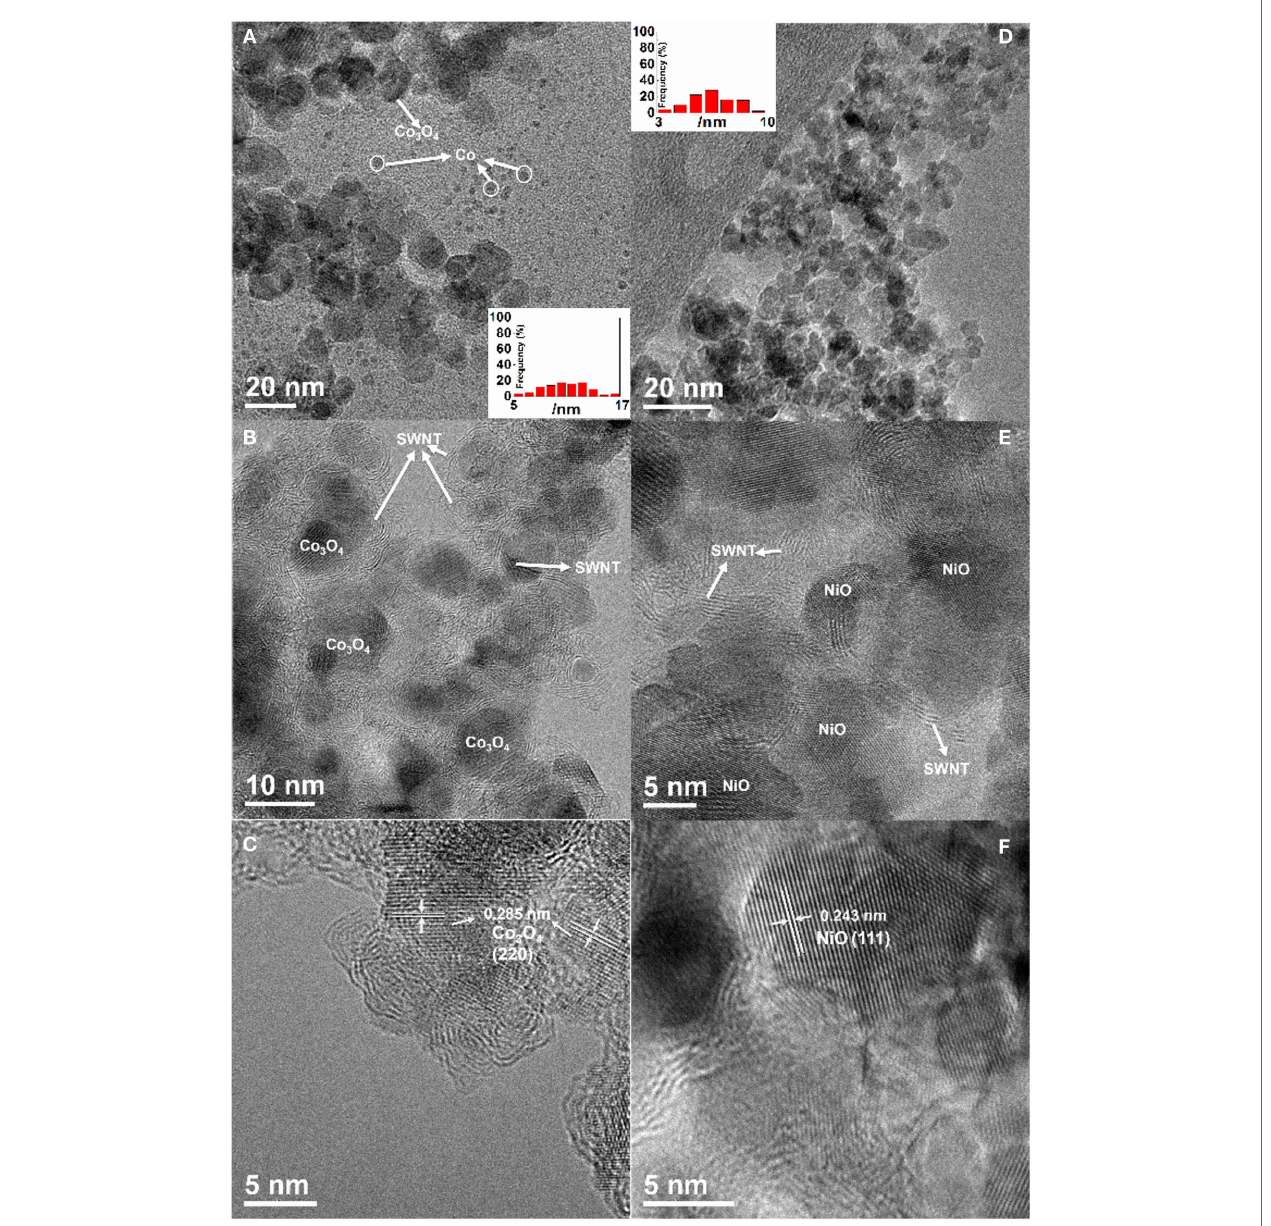
O /SWNT (200°C) and (D–F) NiO/SWNT. Insets: histograms of the nanoparticle size 3 4